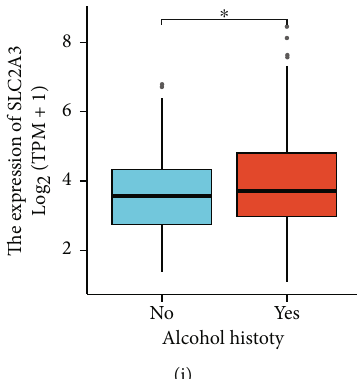
Figure 3: Correlation of SLC2A3 expression with di ff erent clinicopathologic variables including T stage (a), N stage (b), M stage (c), clinical stage (d), gender (e), age (f), histologic grade (g), smoker condition (h), and alcohol history (i). (ns, no signi fi cance, ∗ P < 0 : 05 , ∗∗ P < 0 : 01